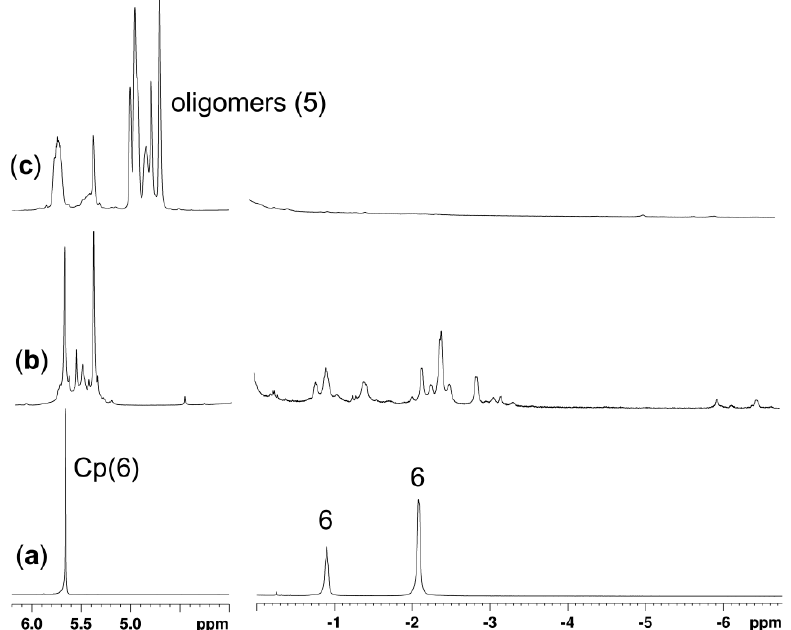
Figure 5. The formation of cationic complexes in the Cp 2 ZrCl 2 -HAlBu i 2 -(Ph 3 C)[B(C 6 F 5 ) 4 ] system and their reactivity towards 1-hexene (intensity of upfield signals is increased): ( a ) Cp 2 ZrCl 2 -HAlBu i 2 system, [Zr]:[Al] = 1:5; ( b ) Cp 2 ZrCl 2 -HAlBu i 2 -(Ph 3 C)[B(C 6 F 5 ) 4 ] system, [Zr]:[Al]:[B] = 1:5:0.5; and ( c